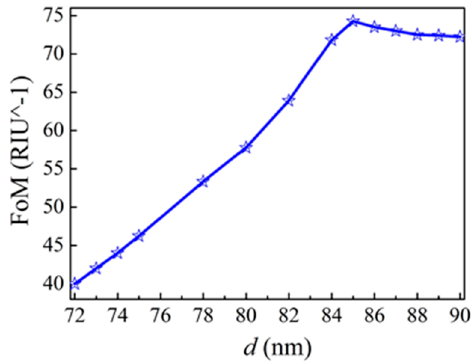
Figure 7. The changes of the figure of merit (FoM) value (resonance peak P 1 ) related to the parameter of d .